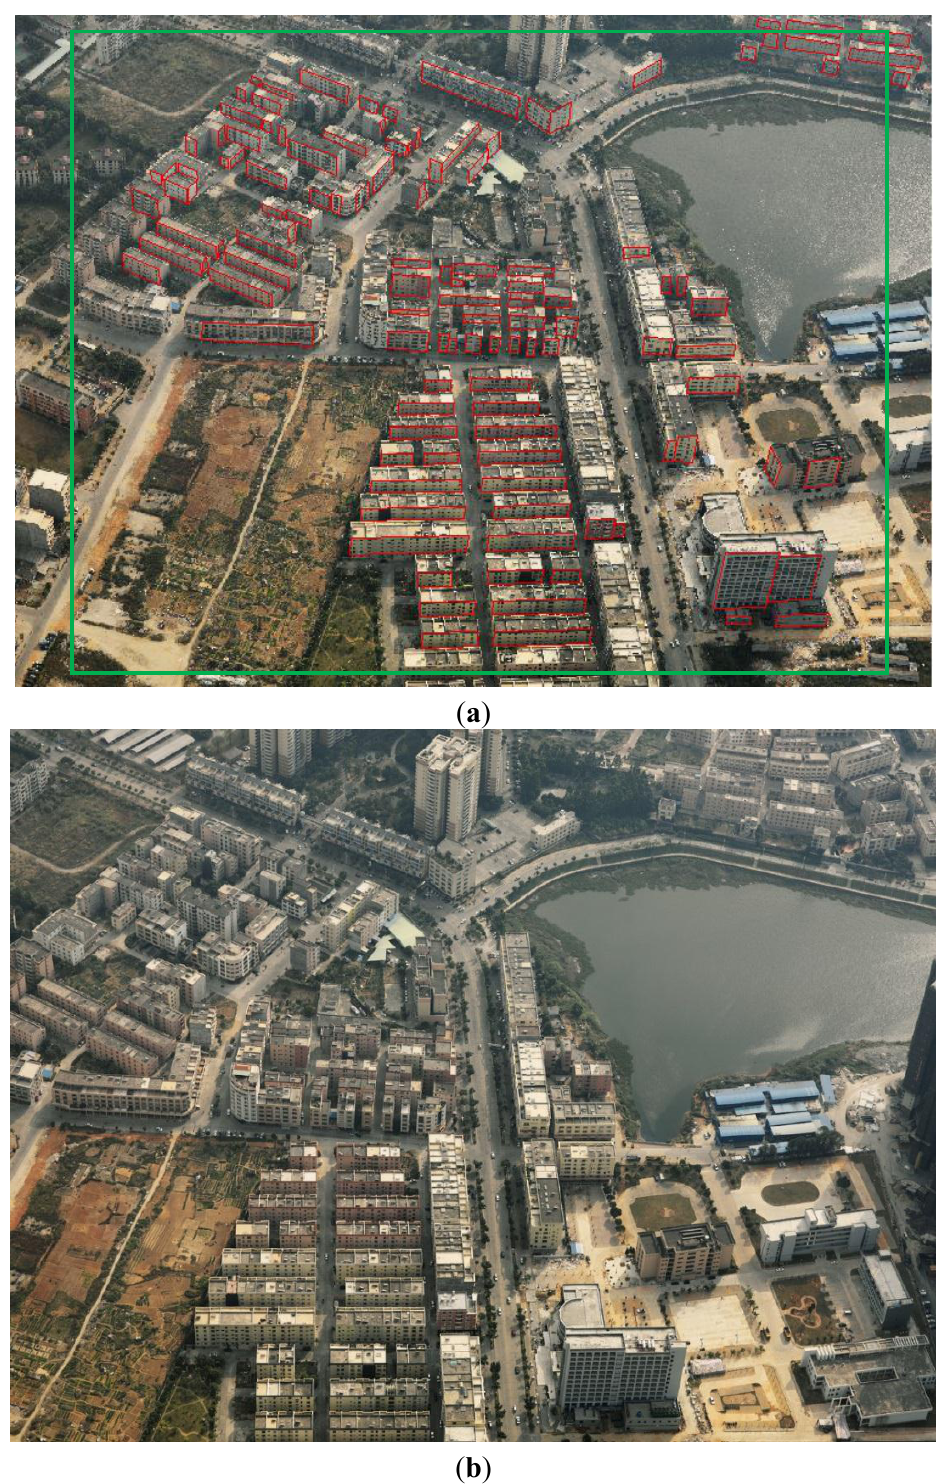
Figure 3. Images of the study area. The red manually drawn boxes depict the potential façades to be processed. Image ( a ) is used as the reference image (the study area is shown by the green box); and image ( b ) is used as the search image. ( a ) Original reference image; ( b ) Original search